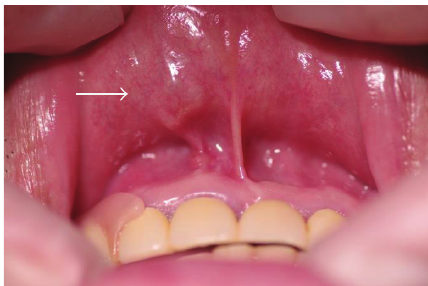
Figure 1: Intraoral view at the first visit. A mass measuring 1.0 × 1.0cm was noted in the upper lip.